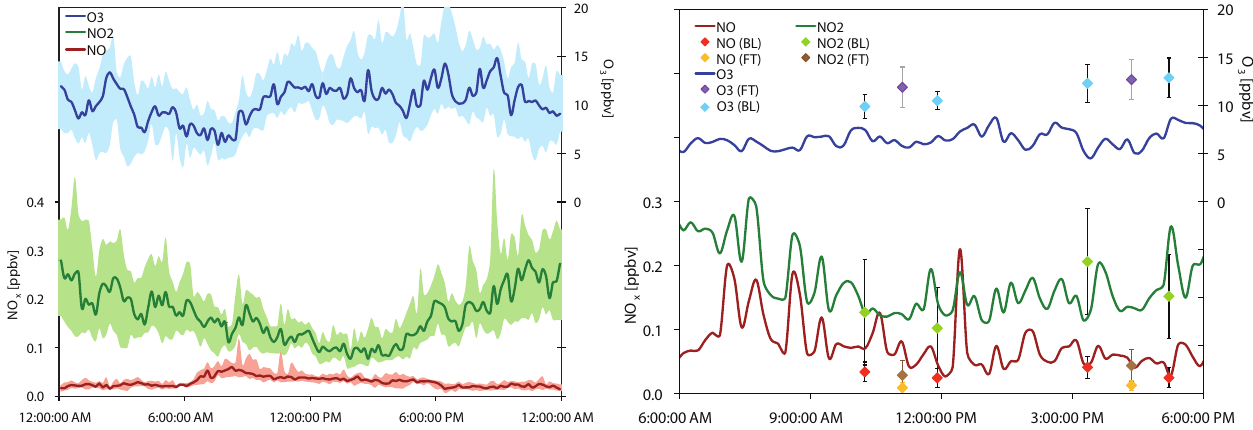
Fig. 2. Left: Median diurnal cycle of ground-based measured NO (dark red), NO 2 (dark green), and O 3 (dark blue) in April. The correspond- ing 25–75 quartile interval is shown with each measurement: NO in pink, NO 2 in light green, and O 3 in light blue. Right: median diurnal measurements in July, shown only for the days when corresponding flight data is available between 06:00 and 18:00h; diurnal profiles are the same color. Average flight data for morning and afternoon profiles above the site are shown as whiskered points and are separated by height. NO boundary layer measurements are show in red (boundary layer) and yellow (free troposphere). NO 2 is shown in light green (boundary layer) and brown (free troposphere). O 3 is shown in light blue (boundary layer) and purple (free troposphere).